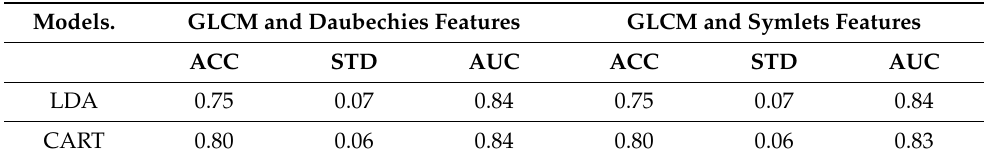
Table 2. Mean accuracy and standard deviation for combined GLCM and Daubechies features and combined GLCM and Symlets wavelet